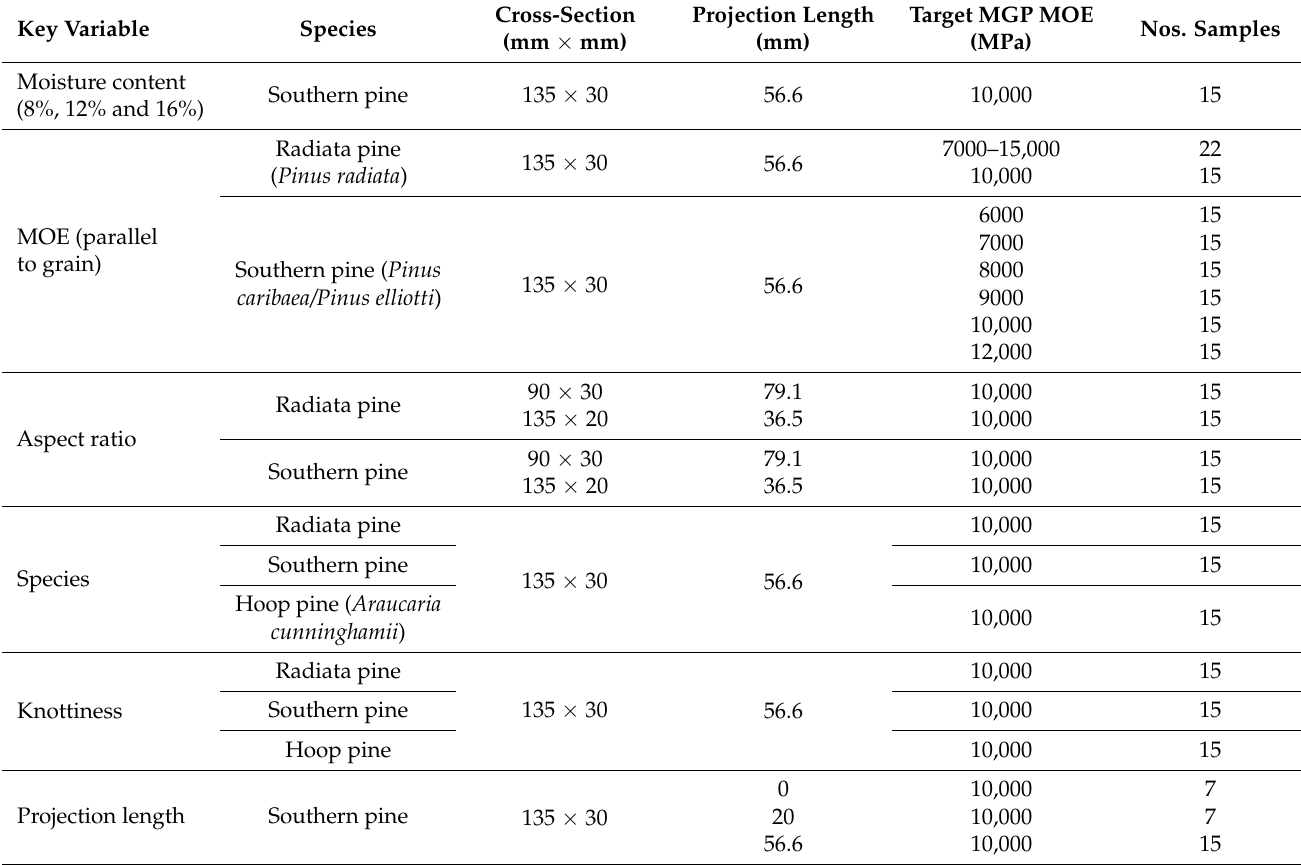
Table 1. Test program with sample dimensions, timber species and number of test